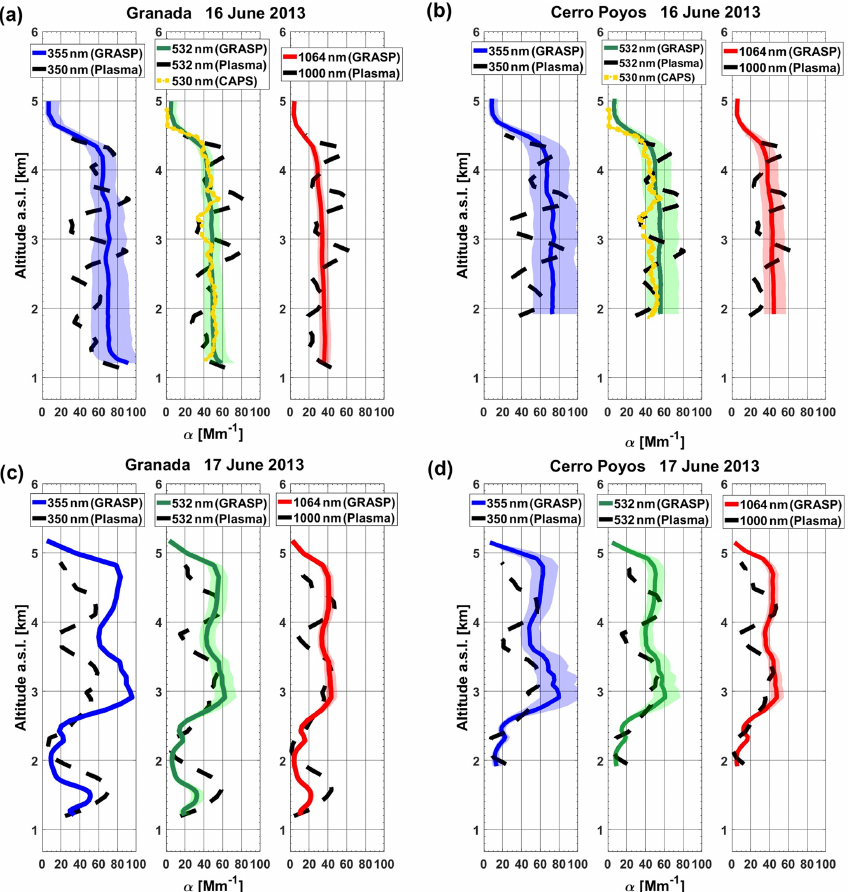
Figure 8. Aerosol extinction coefficient profiles retrieved by GRASP (355, 532 and 1064nm) with its uncertainty (shaded area), PLASMA (350, 530 and 1000nm) and CAPS (530nm) on 16 (a, b) and 17 (c, d) June 2013 at Granada (a, c) and Cerro Poyos (b, d) .